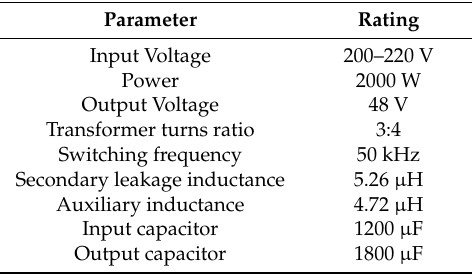
Table 1. DAB-IBDC converter design